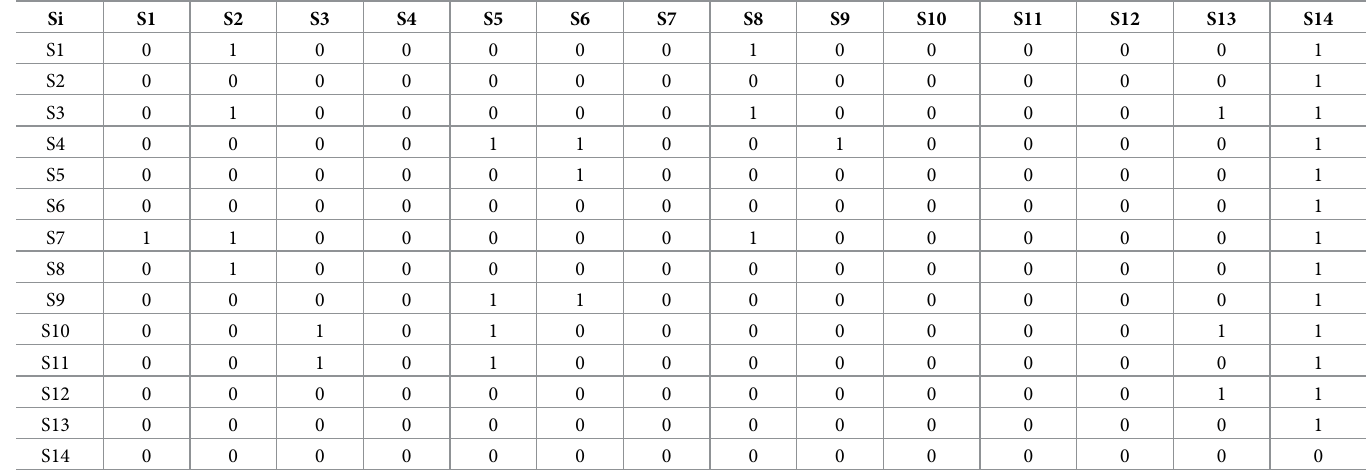
Table 5. The adjacency matrix A .